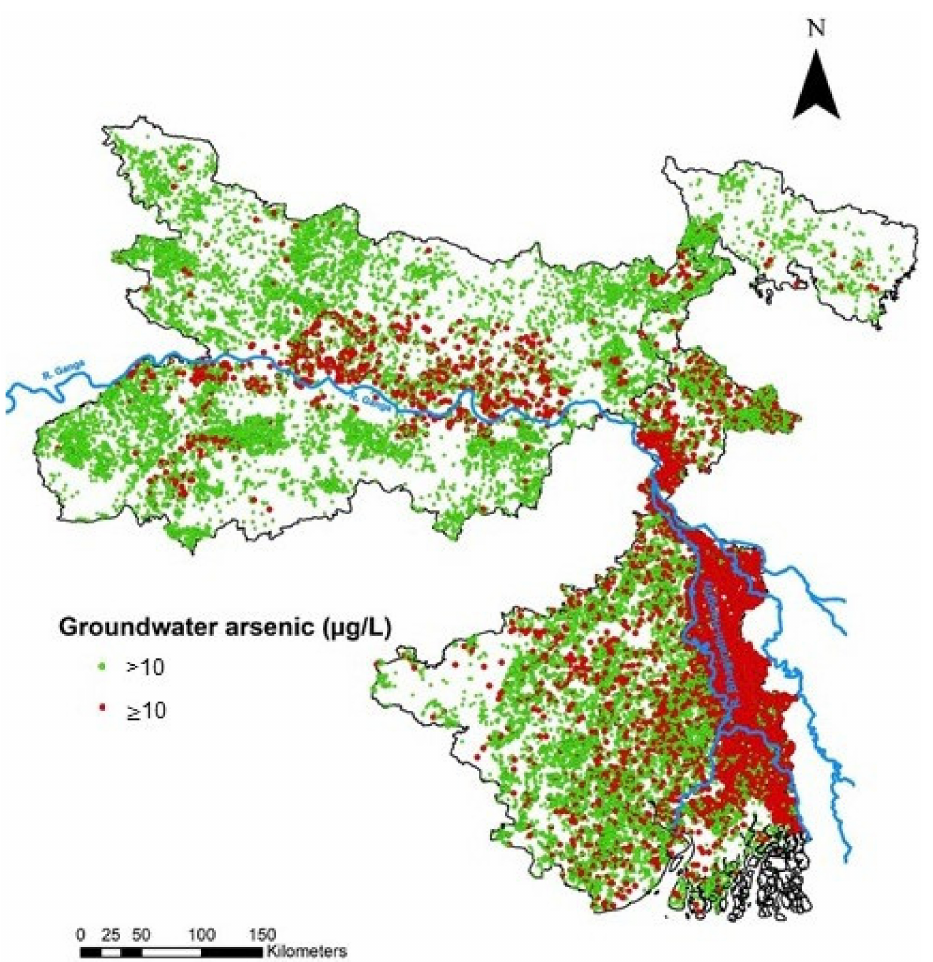
Figure 2. Groundwater arsenic concentration from field-observed groundwater data for the states of Bihar ( n = 112,308) and West Bengal ( n =